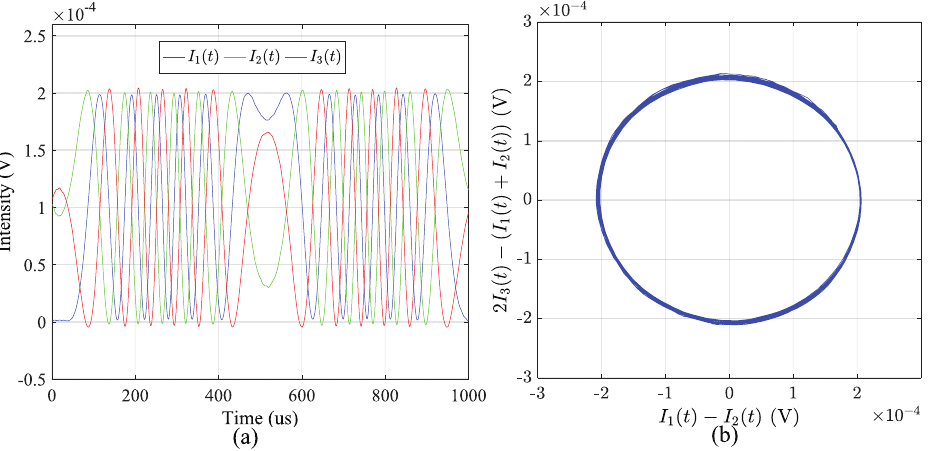
Figure 6. The implementation result of the automatic time window locating method. ( a ) the extracted three intensities; ( b ) the Lissajous curve of 2 I 3 − ( I 1 + I 2 ) versus I 1 − I 2